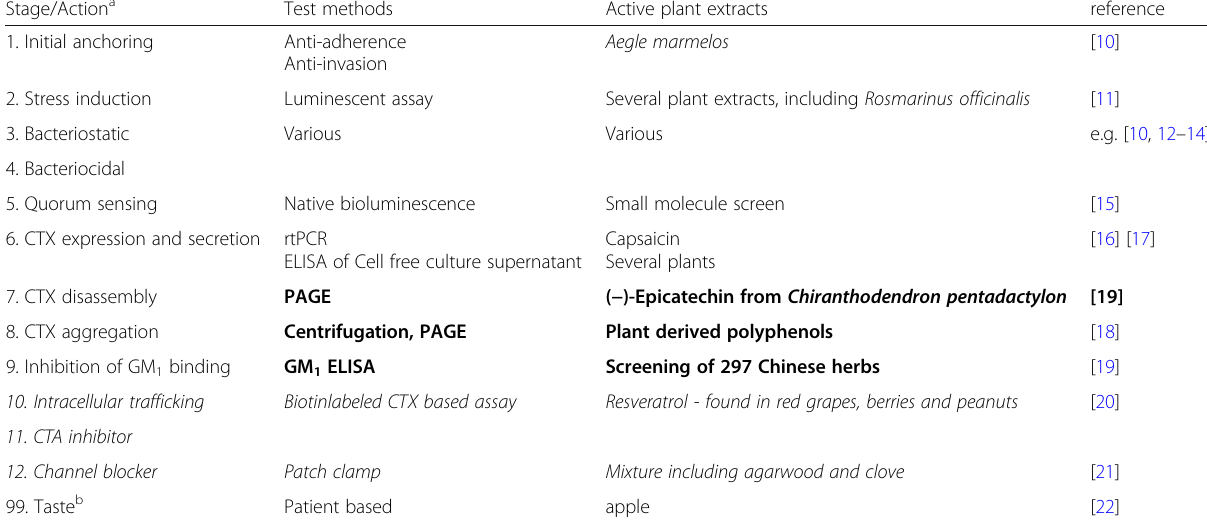
Table 1 Stages of V. cholerae